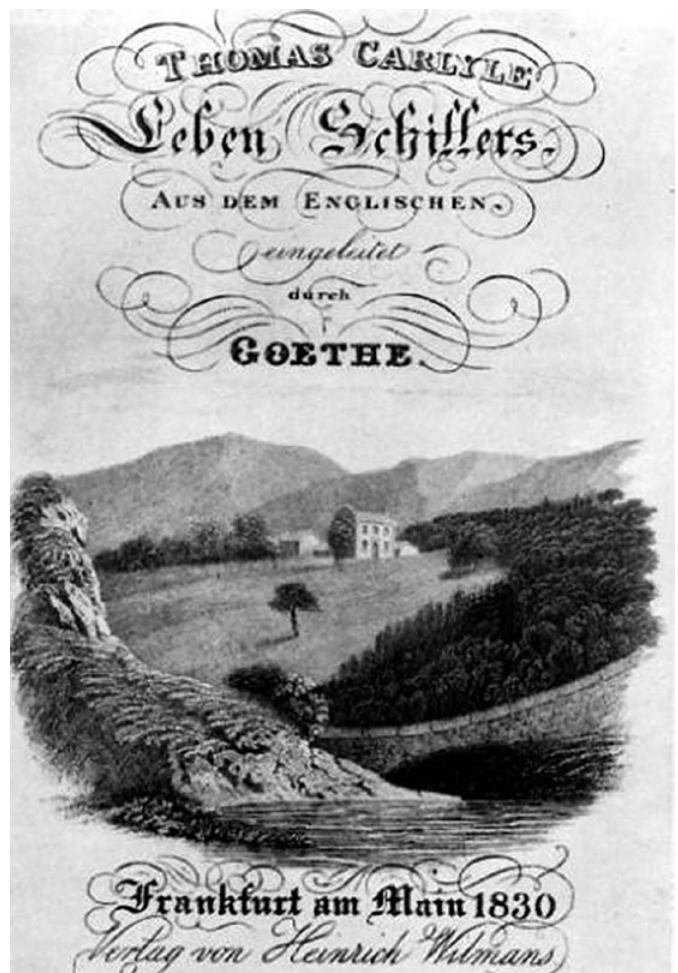
Figure 1.1 Carlyle’s Life of Schiller , frontispiece to the German translation based on the watercolour by George